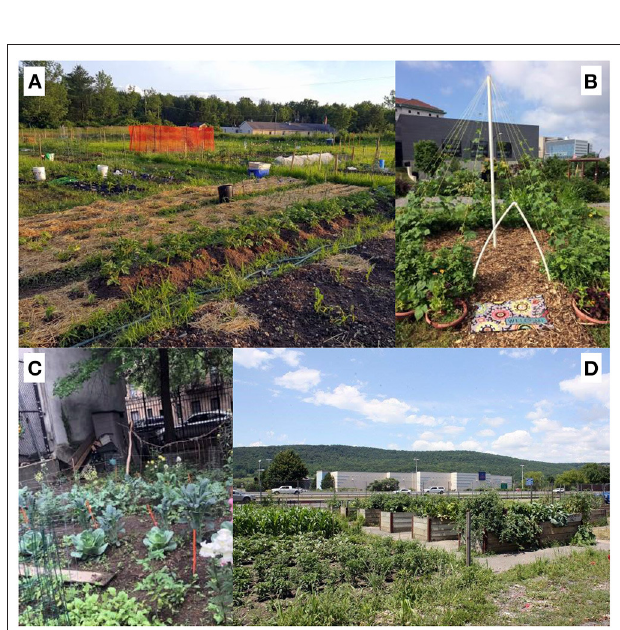
FIGURE 2 | Photographs of community gardens involved in this study: (A) Cornell Community Garden (Ithaca, NY), (B) Pelion Community Garden © Caesandra Seawell (Buffalo, NY), (C) Shugah Baybees Garden (Harlem, New York City, NY), and (D) Otsiningo Gardens (Binghamton,